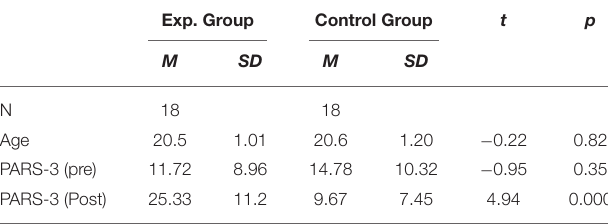
TABLE 1 | Mean and SD of demographics and PARS-3 score of